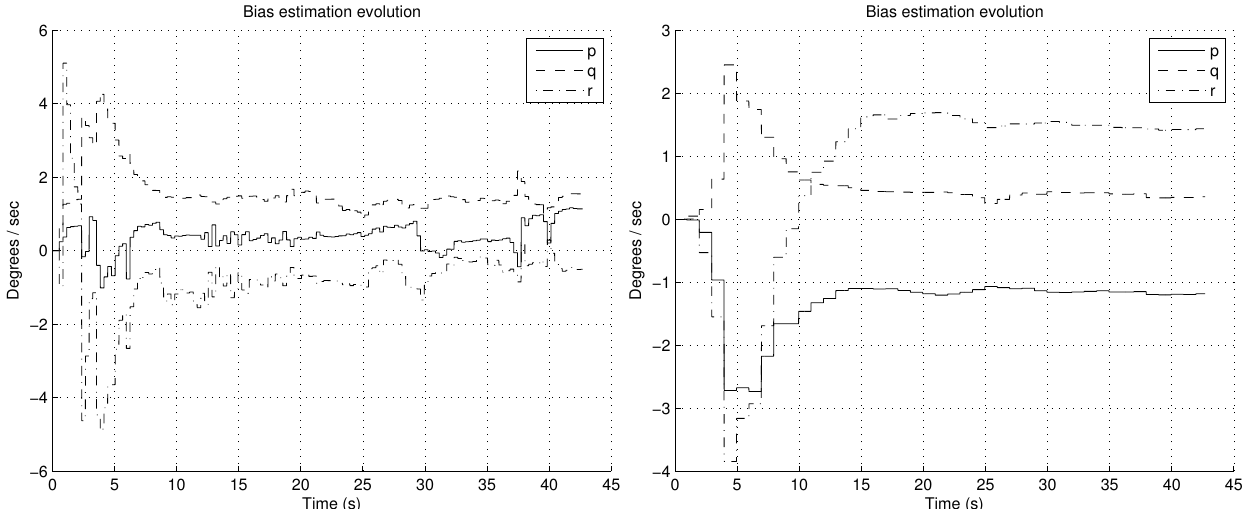
Figure 6. Estimation of the biases of the gyroscopes, employing TRIAD at the left and FOAM at the right during the aerobatics simulation shown in Figure